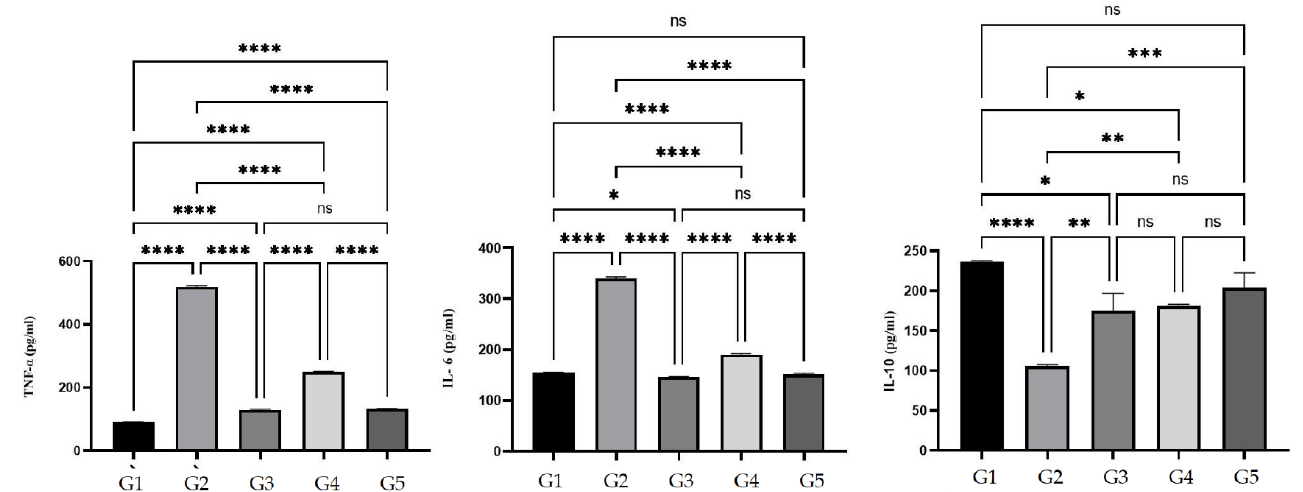
Figure 9. The effect of p -Cymene on TNF- α , IL-6 and IL-10 in ethanol-induced gastric ulcers in rats. Pre-treatment groups: normal control 0.5% CMC (G1), ulcer control 0.5% CMC (G2), omeprazole 20 mg/kg (G3), p -Cymene 30 mg/kg (G4), p -Cymene 60 mg/kg (G5). Values presented as means (n = 6). ns, non-significant; *, p < 0.05; **, p < 0.01; ***, p < 0.001; ****, p < 0.0001.